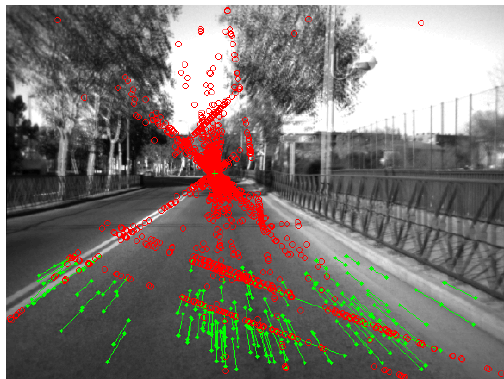
Figure 2. Calibration of the deviation of the yaw angle in an urban environment: superposition of two consecutive images, where the consecutive positions of each point of interest are connected by green lines, while the intersections of the straight lines appear as red